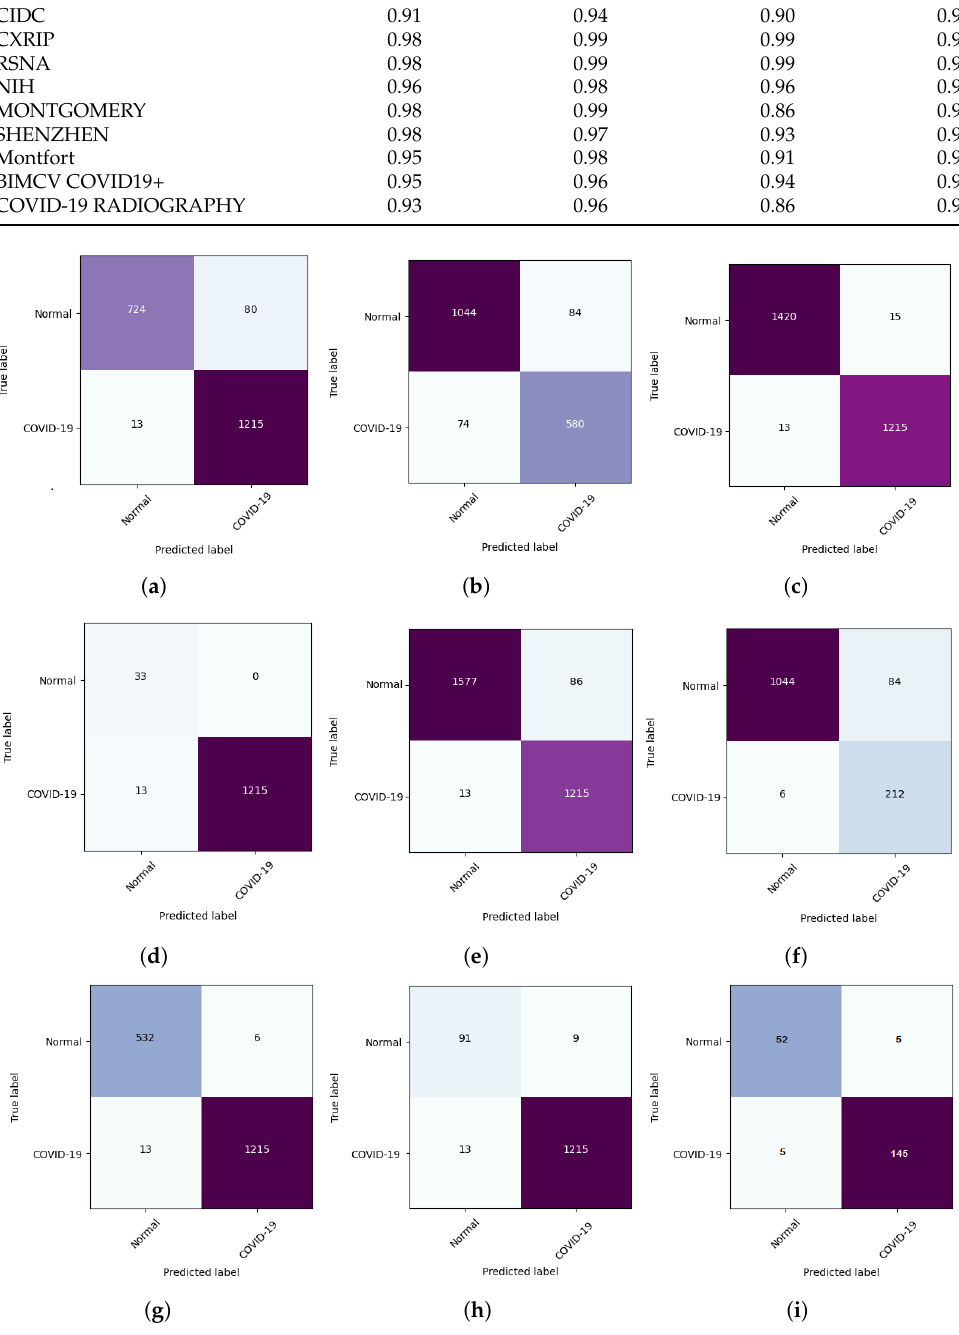
Figure 21. Confusion matrices of DeepCCXR-Bin (COVID-19 vs. normal): ( a ) BIMCV